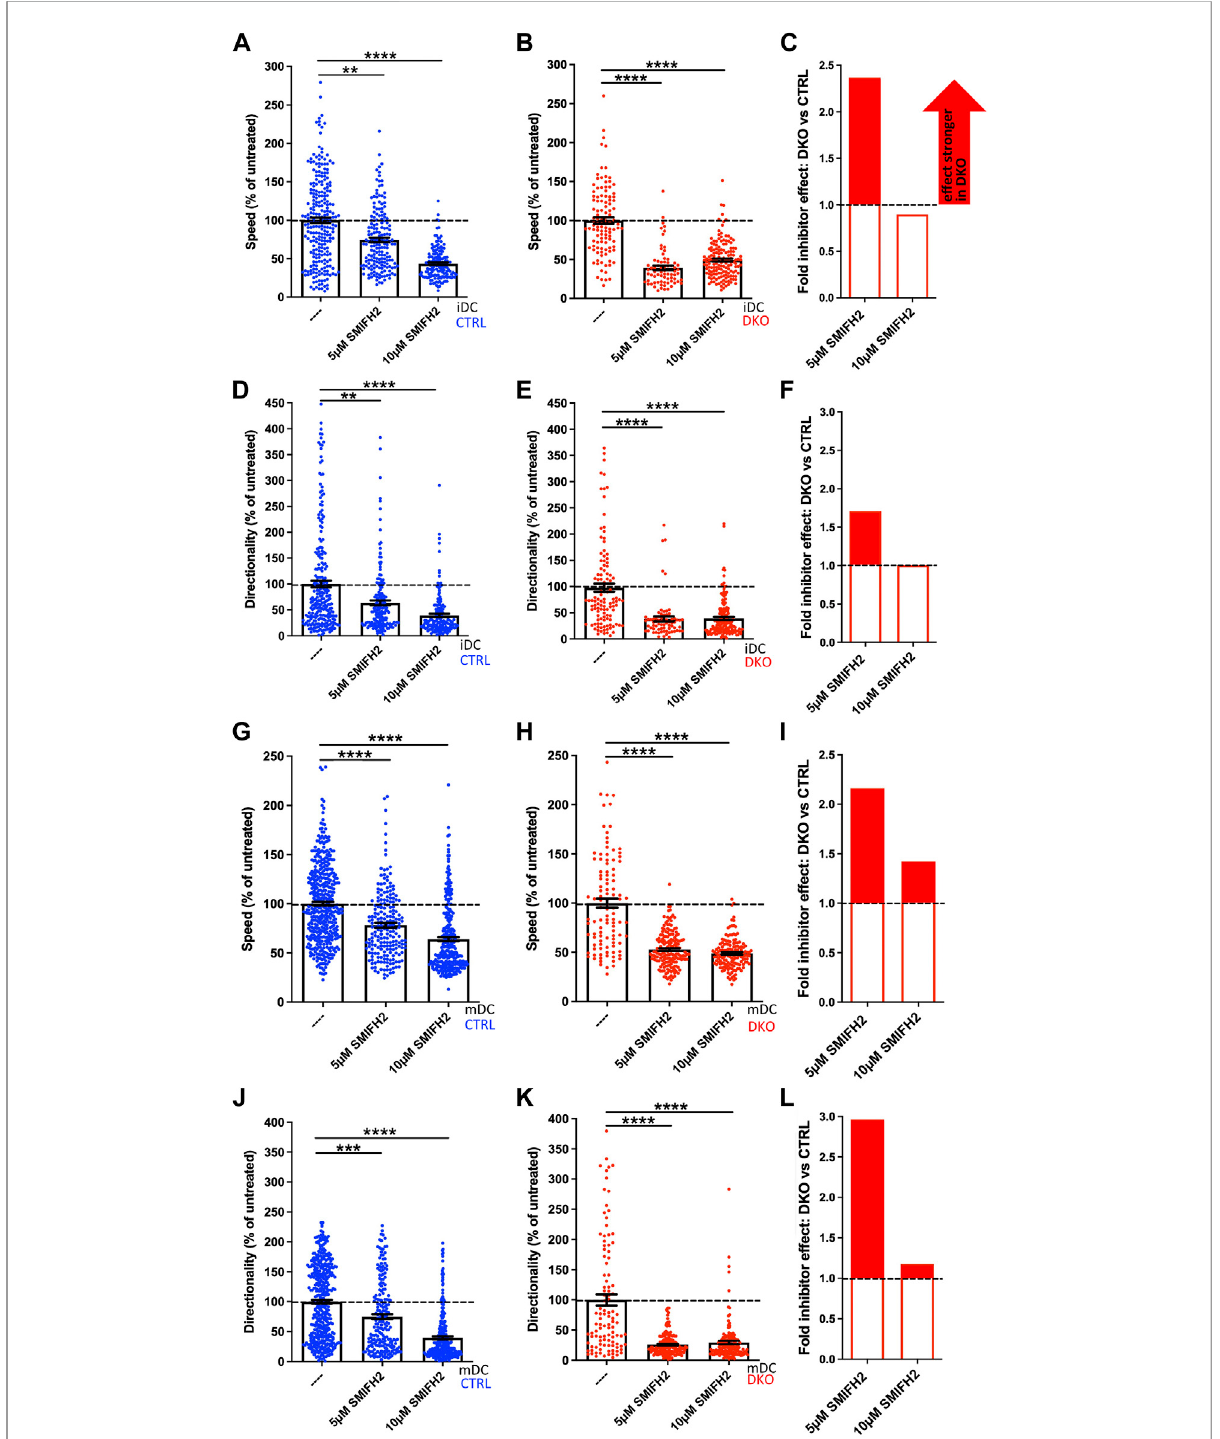
EVL/VASP DKO DCs show increased vulnerability to treatment with the formin inhibitor SMIFH2. Immature (A – F) or mature (G – L) control and DKO DCs were embedded into 1.9 mg/ml collagen gel. The upper gel surface was covered with medium containing 650 ng/ml CCL19. DCs were either left untreated, or incubated with 5 µM or 10 µM of the formin inhibitor SMIFH2 (present in gel and medium). DC migration was monitored by bright- fi eld real-time microscopy for 6 h. Images were obtained at 2 min intervals and analyzed in automated manner. Speed (A,B,G,H) and directionality (D,E,J,K) aredepictedasmean±SEMafternormalizationtotheuntreatedconditionoftherespectivegenotype(N(iDCs)=72-253cells from 2-3 independent experiments; N (mDCs) = 106-438 cells from 2-4 independent experiments; statistical analysis by Kruskal – Wallis test